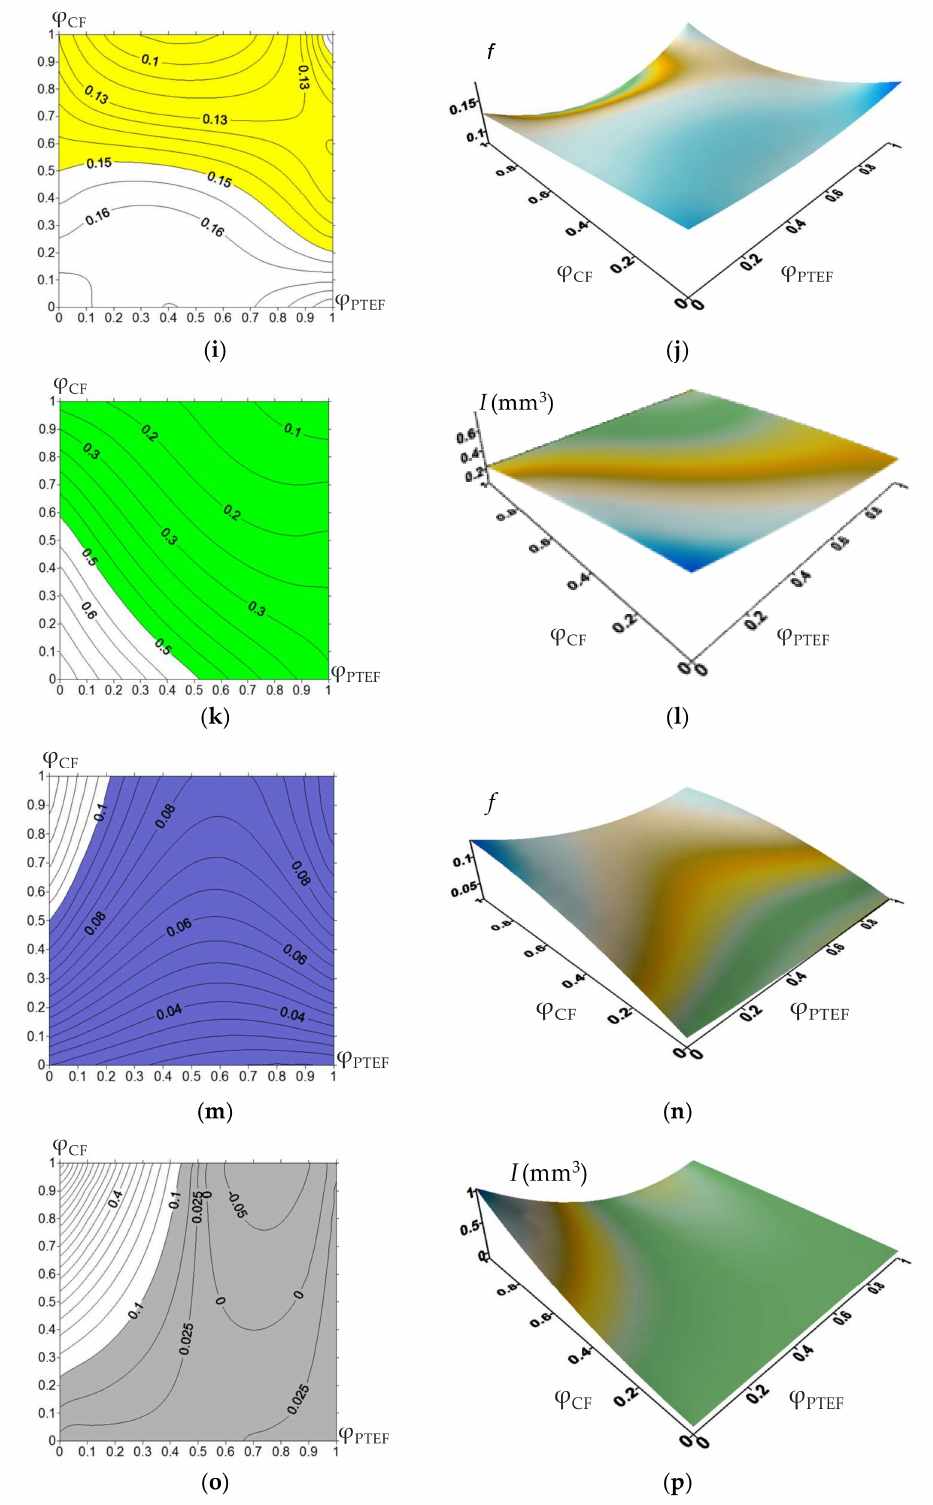
Figure 6. Operational properties of the PPS-based composites vs. degree of CF and PTFE filling: bending modulus ( a , b ), flexural strength ( c , d ), bending strain ( e , f ), Shore D hardness ( g , h ), friction coe ffi cient on metal counterpart ( i , j ), volumetric wear on metal counterpart ( k , l ), friction coe ffi cient on metal counterpart ( m , n ), and volumetric wear on metal counterpart ( o , p